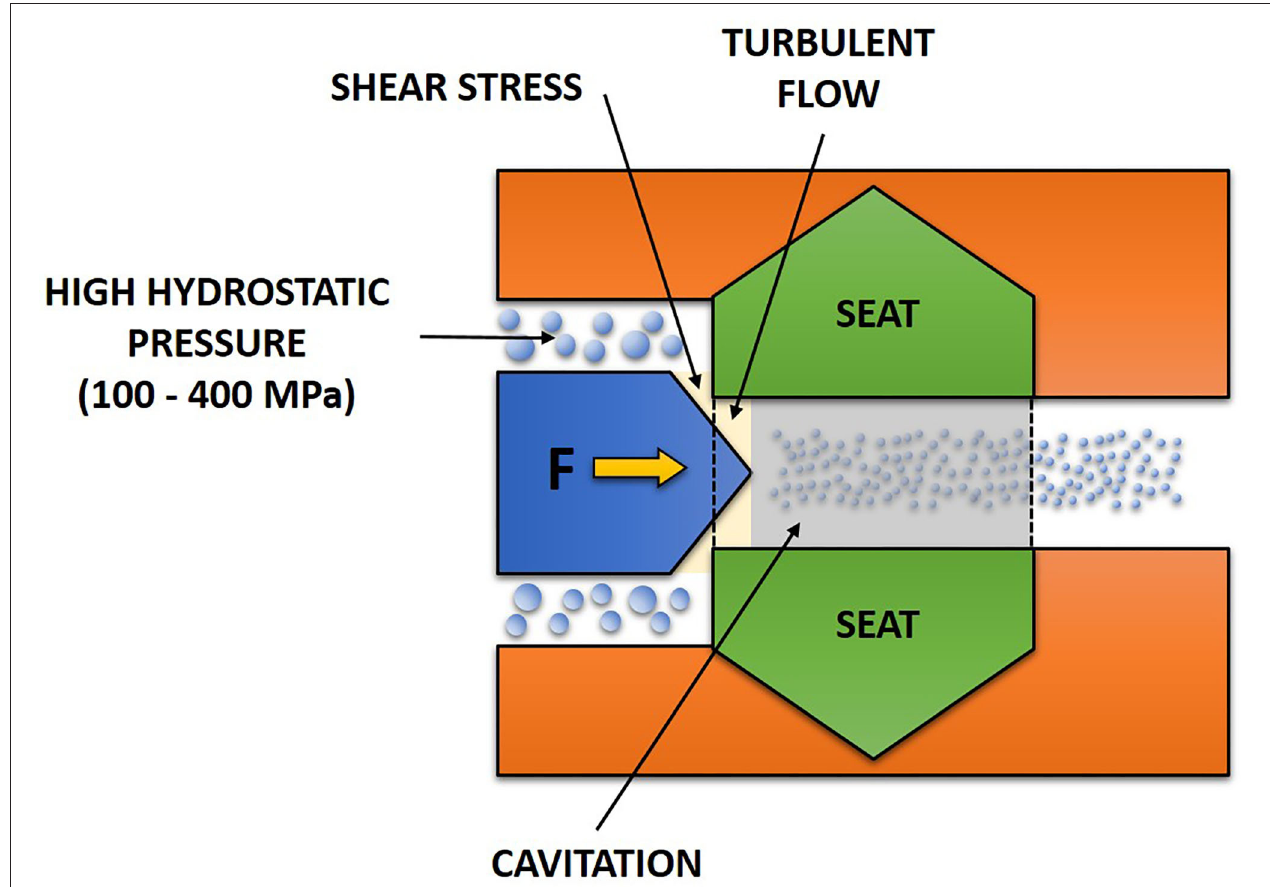
FIGURE 3 | Occurrence of turbulent flow and cavitation in a fluid during high-pressure